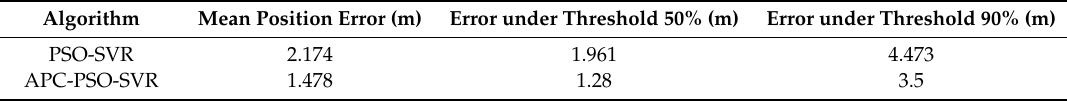
Table 4. Comparison of two positioning performances before and after